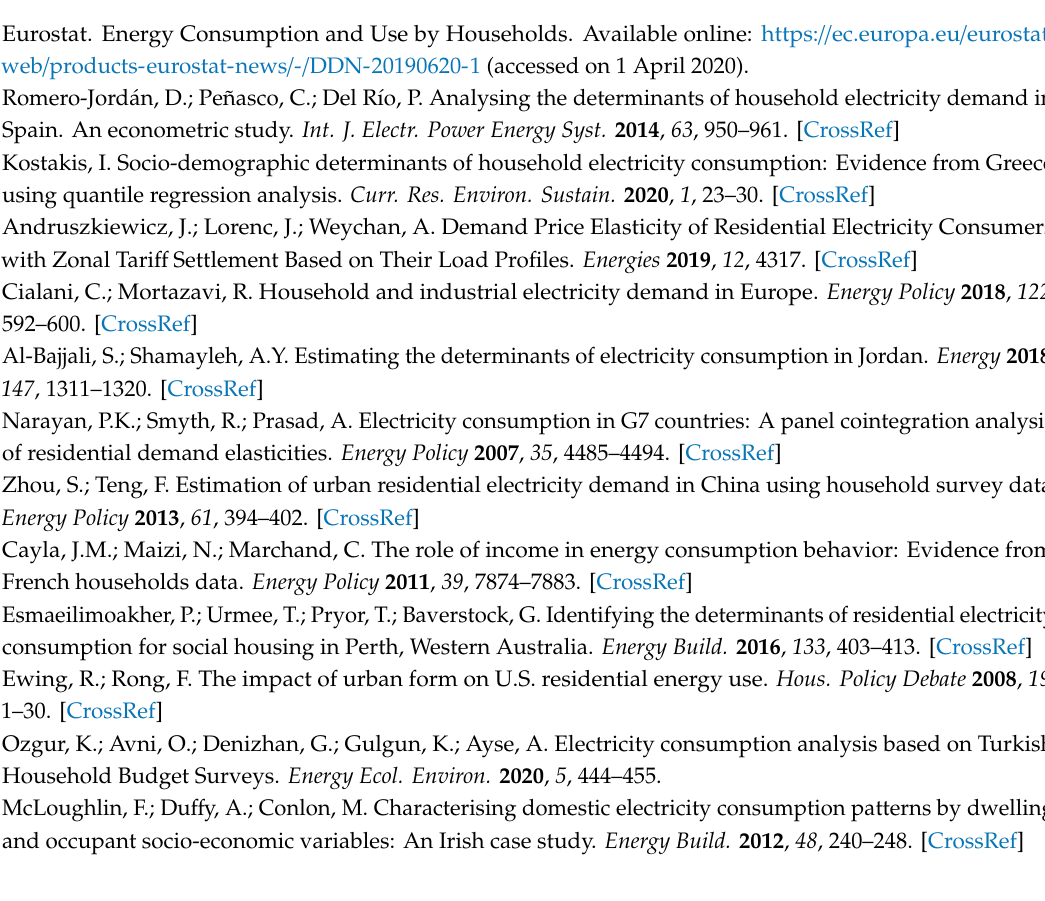
Figure S1: Average electricity prices in the three periods for di ff erent consumption bands ( € / kWh, nominal prices, all taxes and levies included), Table S2.1: Increase in the average level of electricity prices in 2013–2017, Figure S2: Evolution of electricity prices in Spain and the EU in the < 1000 kWh band ( € / kWh, nominal prices, all taxes and levies included), Figure S3: Evolution of electricity prices in Spain and the EU in the 1000–2500 kWh band ( € / kWh), Figure S4: Evolution of electricity prices in Spain and the EU in the 2500–5000 kWh band ( € / kWh), Figure S5: Evolution of electricity prices in Spain and the EU in the 5000–1500 kWh band ( € / kWh), Figure S6: Evolution of electricity prices in Spain and the EU in the > 15,000 kWh band ( € / kWh), Table S2: Countries with the highest household electricity prices in the EU in the second semester (S2) of 2017 and position of Spain in the